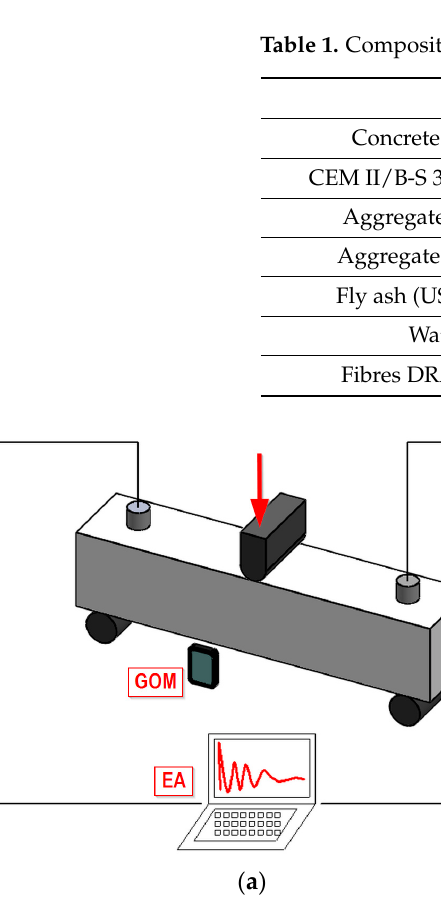
Table 1. Compositions of samples.